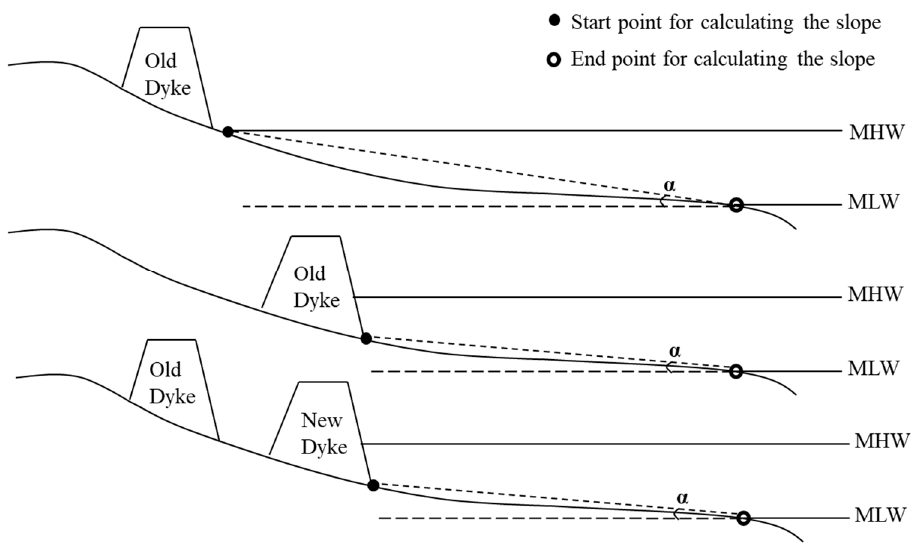
J. Mar. Sci. Eng. 2021 , 9 , x FOR PEER REVIEW Figure 4. Scheme of calculating the intertidal flat slope. Figure 4. Scheme of calculating the intertidal flat slope.